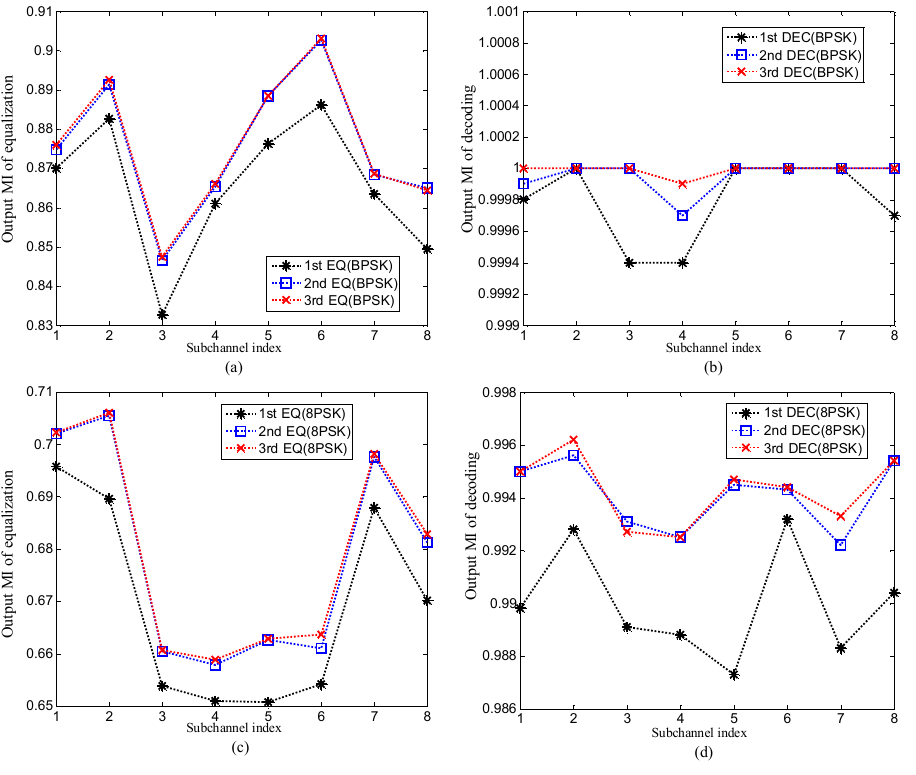
=2dB E : ( a ) and 0 b